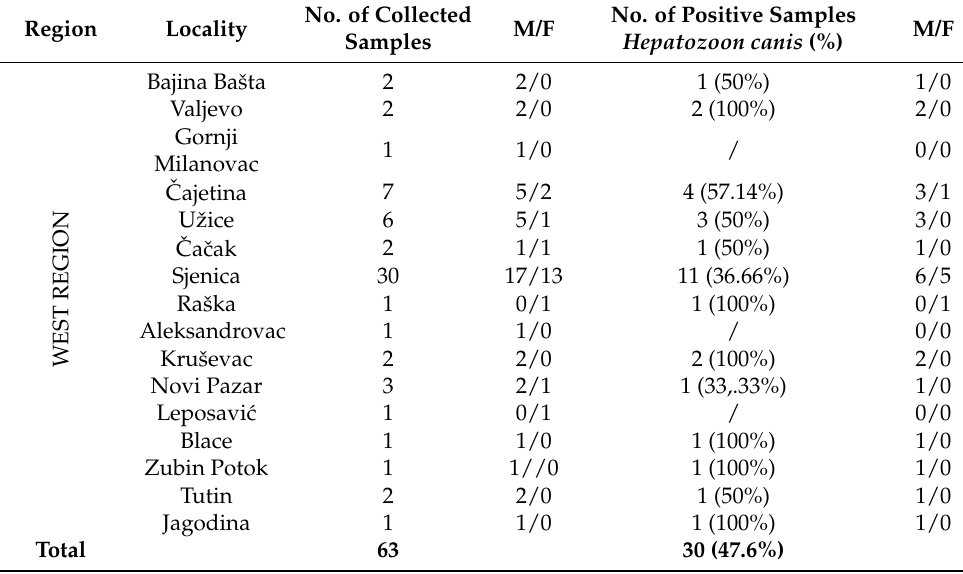
Table 1. Distribution of grey wolf ( Canis lupus ) samples based on sampling locality, gender, and prevalence of Hepatozoon canis